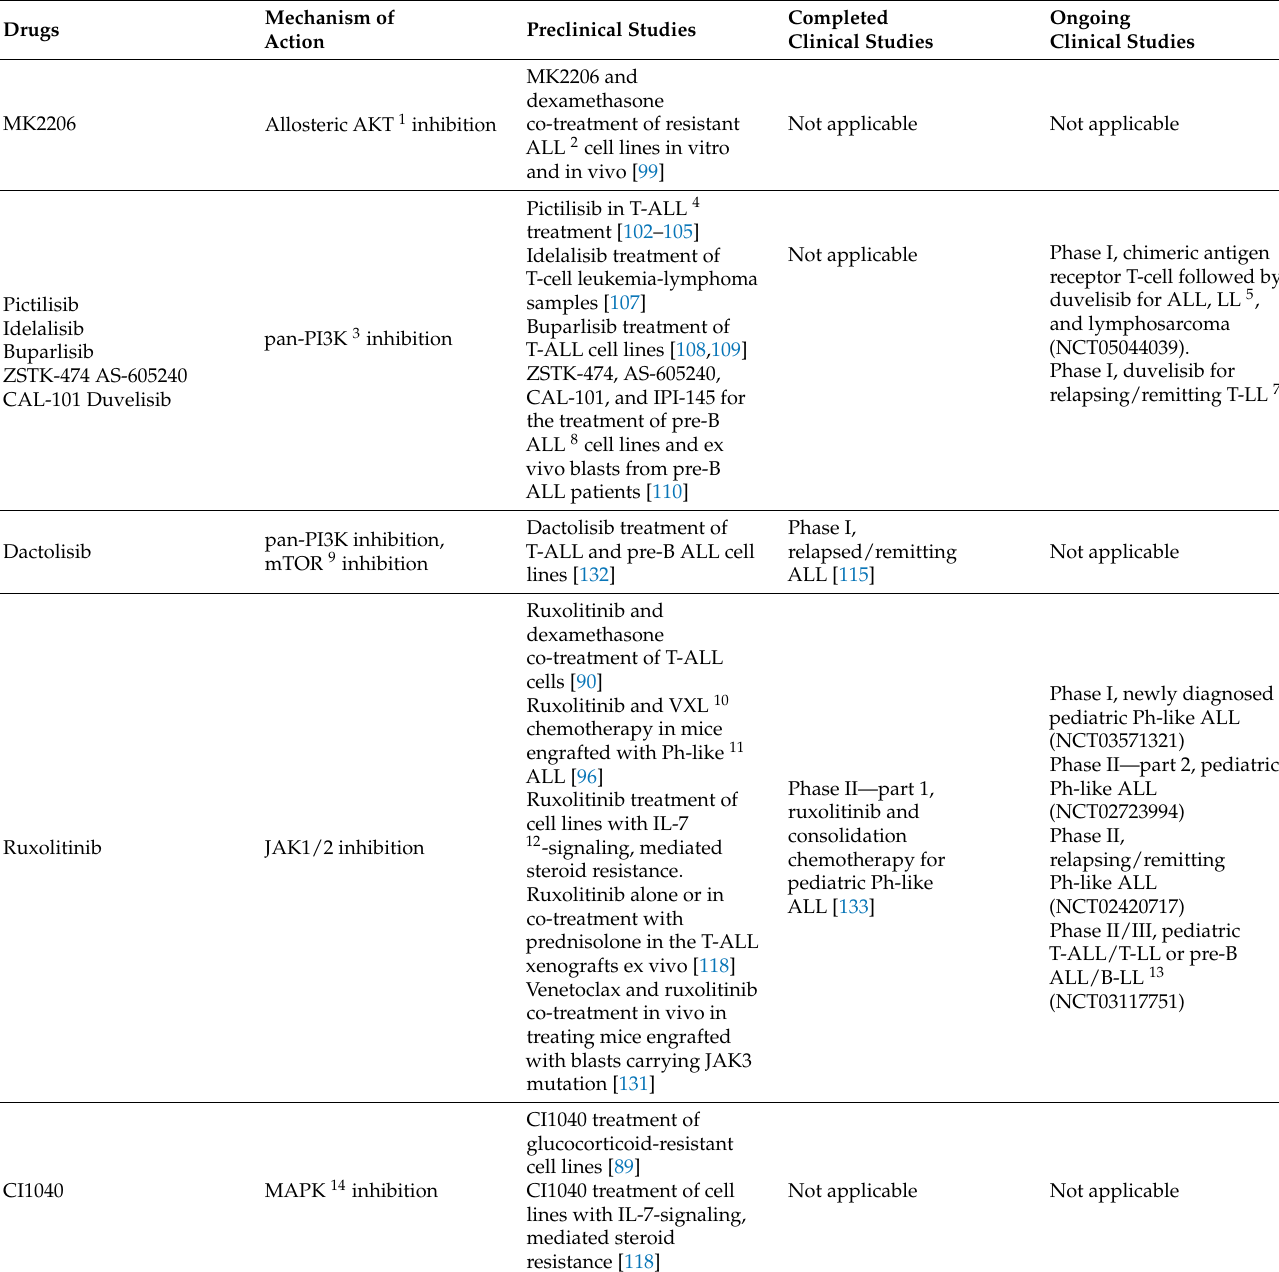
Table 1. Targeting signaling pathways in ALL